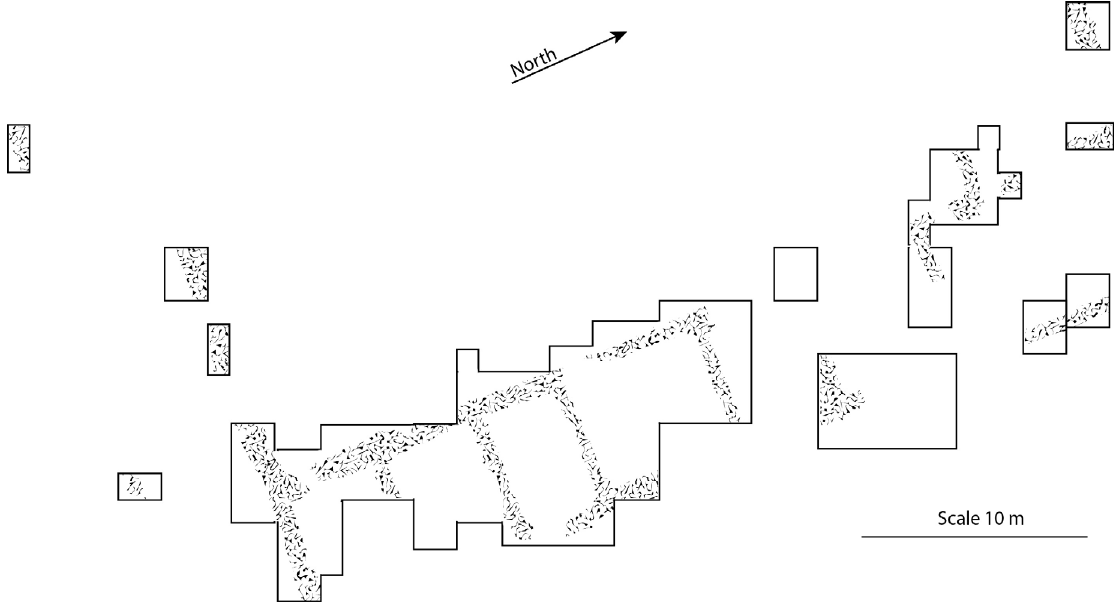
Figure 8. The Spanish quadrangle known as San Pedro y San Pablo, at what is now Sanchez Adobe County Park in Pacifica. Excavation map